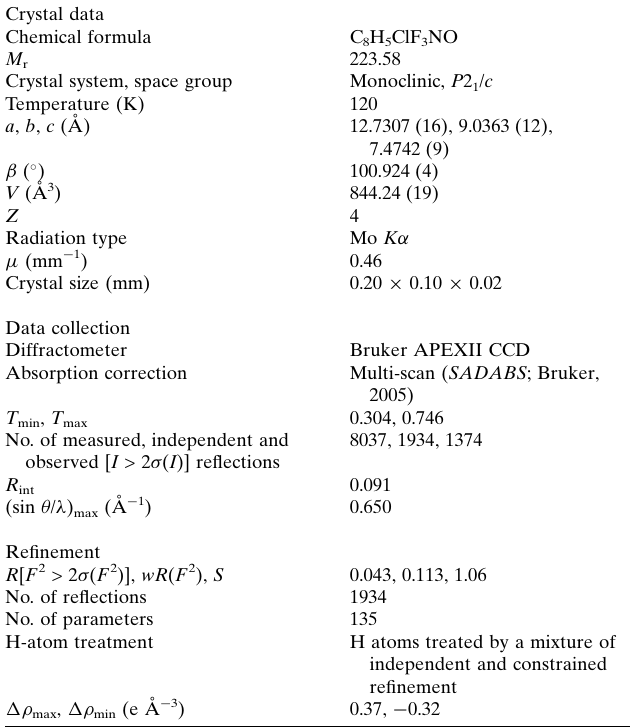
Table 2 Experimental details. Crystal data Chemical formula